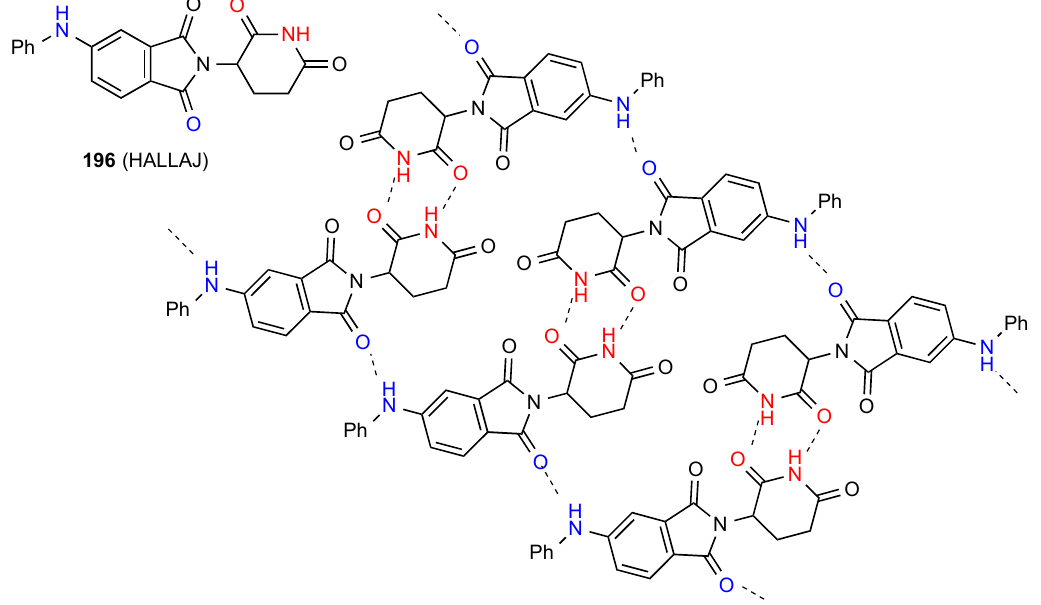
Figure 59. Structure adopted by compound 196.